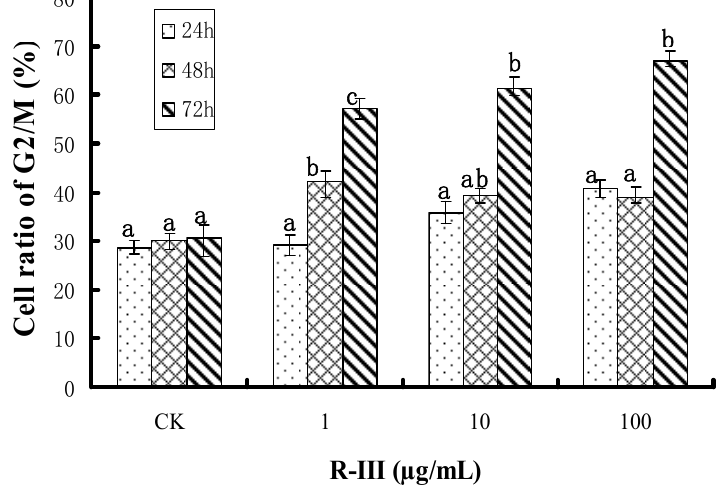
Figure 3. Effects of R-III on cell cycle. The cells were grown in presence of 1, 10, and 100 μ g/mL of R-III for the times shown in the figure. Cell cycle was arrested in G2/M in Sf9 cells and showed a time- and dose-dependent manner. Cells that treated with 0.1% DMSO were used as control. The error bars represent mean ± SEM for data derived from three repetitions. Treatment means sharing the same letter were not significantly different from each other ( P < 0 .